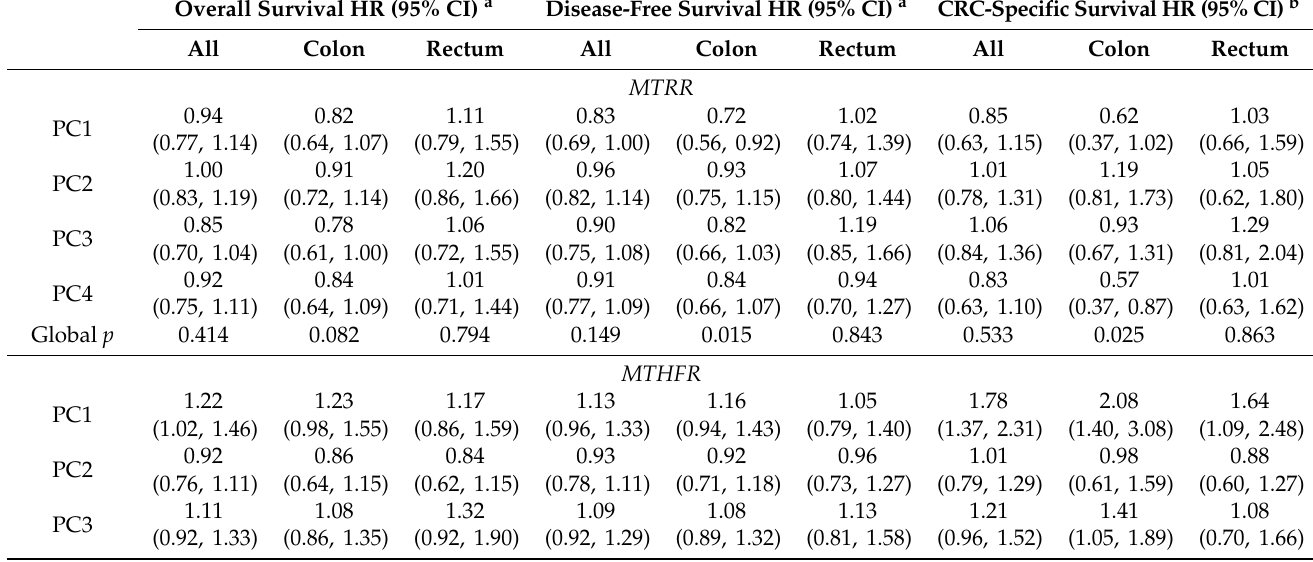
Table 2. Associations between MTRR and MTHFR genes and colorectal cancer overall, disease-free and CRC-specific